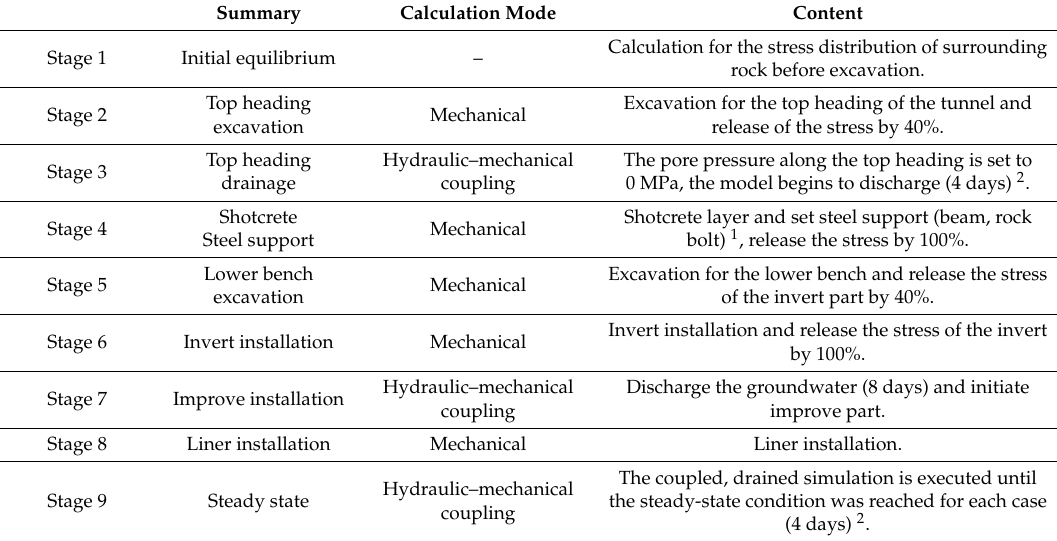
Table 3. The simulation